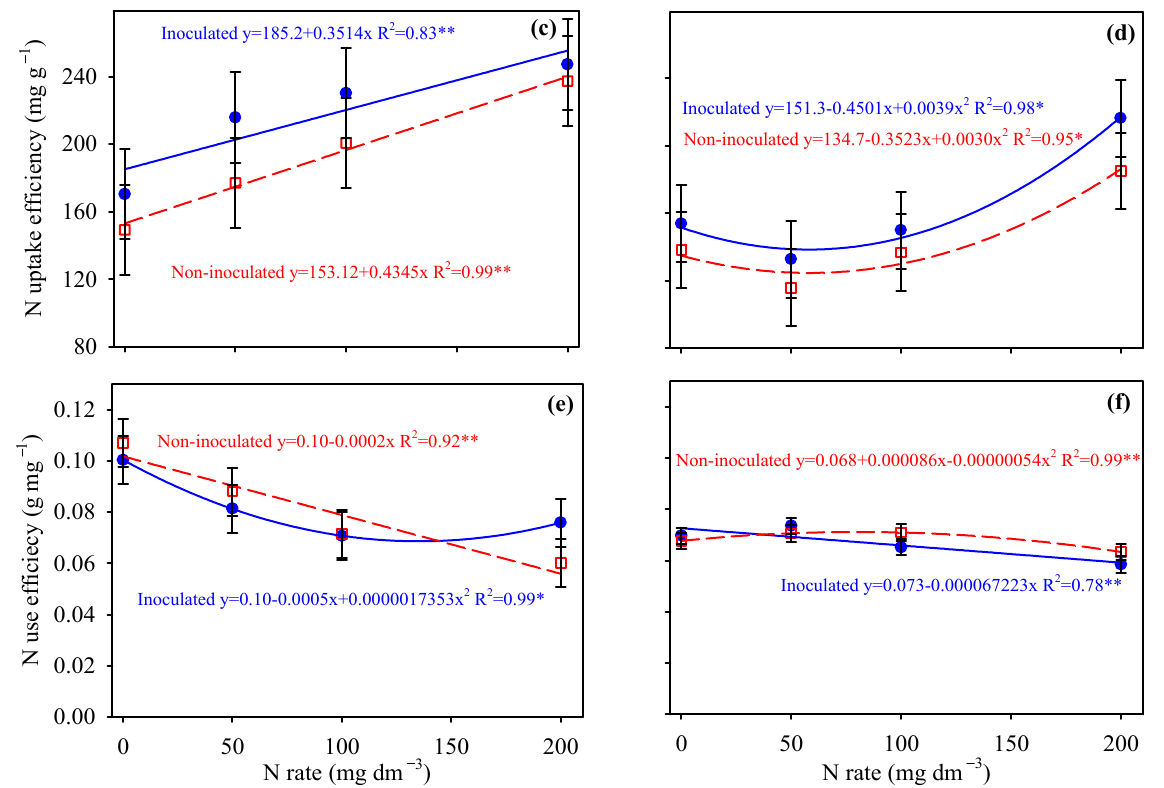
Figure 5. Amount of N accumulated in the whole plant ( a , b ), N-uptake efficiency ( c , d ), and N-use efficiency ( e , f ) of cassava in response to N application rates and A. brasilense inoculation in natural and disinfected soil. Bars represent the least significant difference between A. brasilense inoculation in the same N rate at p < 0.05 according to the LSD test. * p < 0.05; ** p < 0.01.